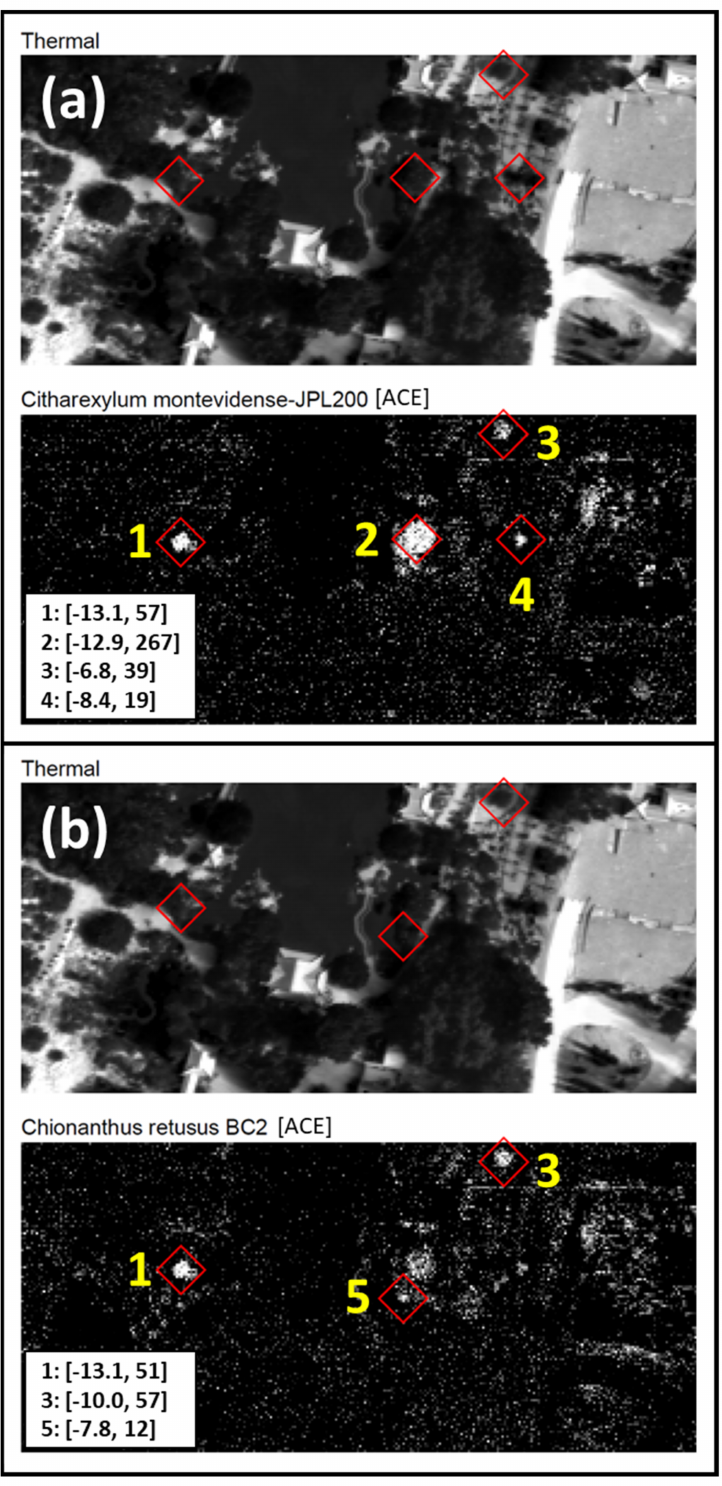
Figure 14. Specimens of Chionanthus retusus mis-ID’d by ( a ) the Citharexylum montevidense spectrum and ( b ) correctly ID’d by the Ch. retusus